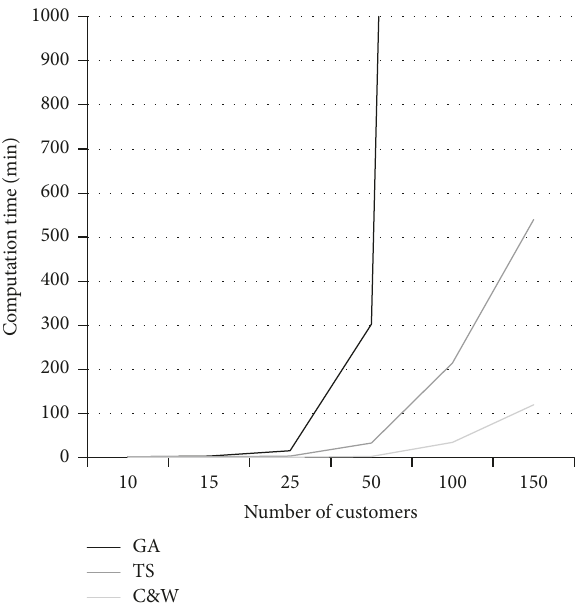
Figure 6: Computation times depending on the number of cus- tomers for the three soft-computing methods